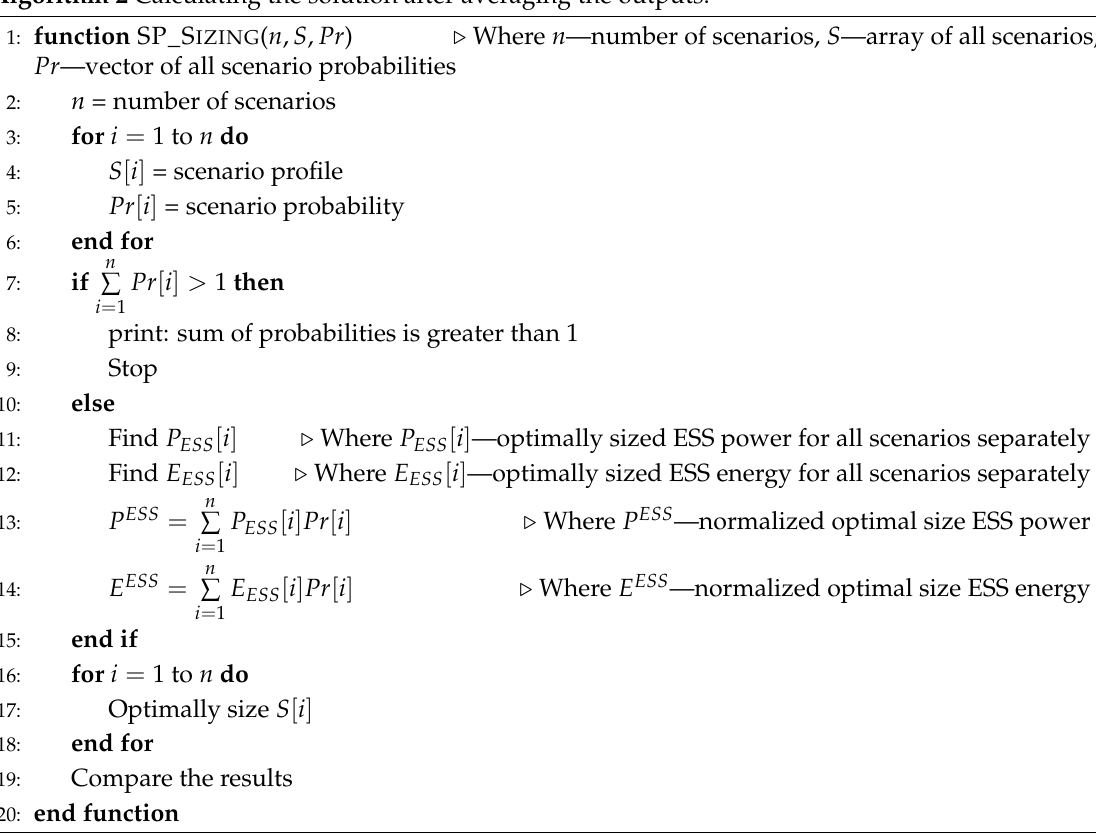
Algorithm 2 Calculating the solution after averaging the